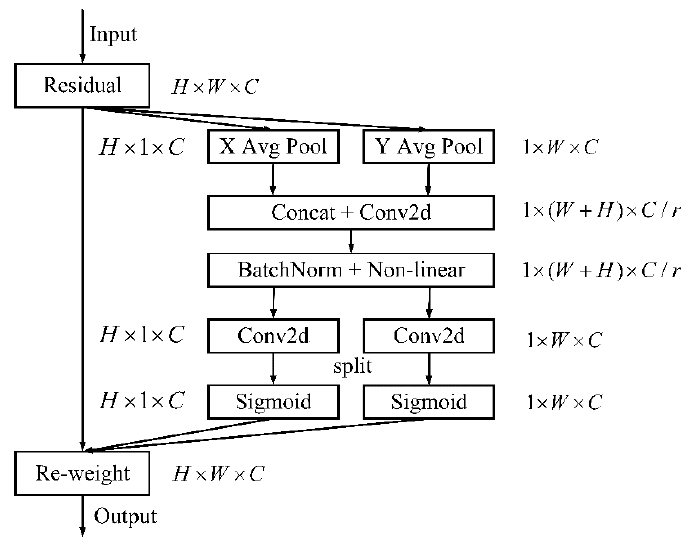
Figure 9. Schematic diagram of SE attention mechanism module.